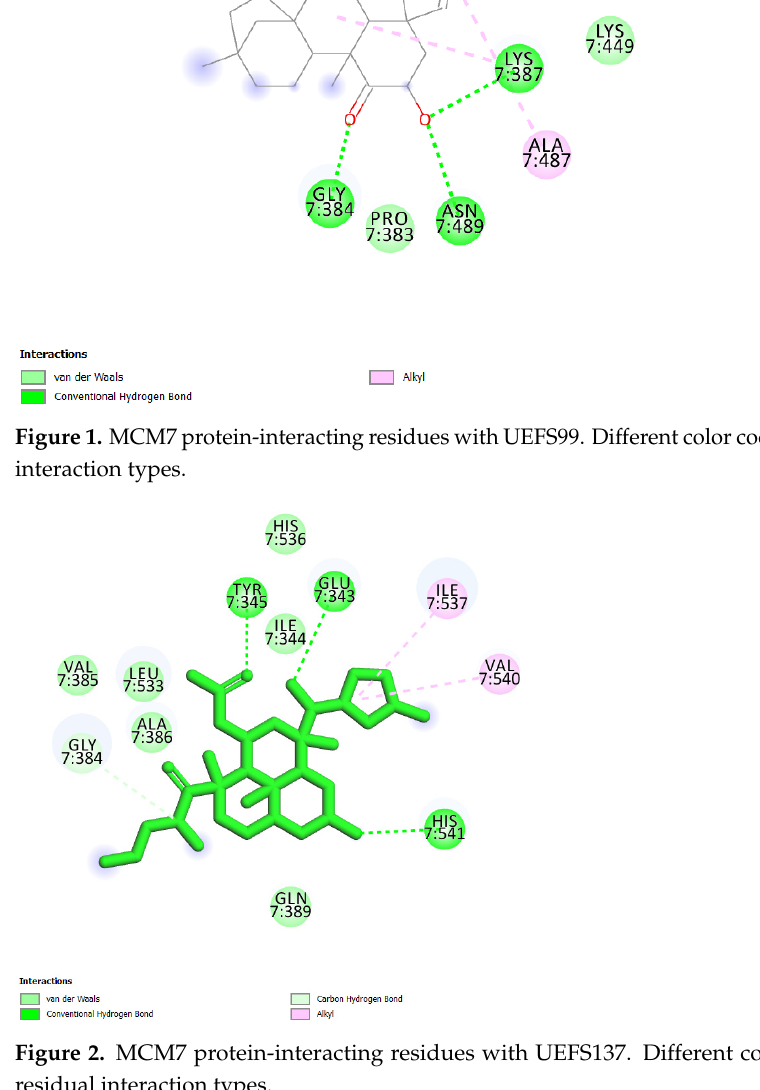
Figure 3. MCM7 protein-interacting residues with UEFS428. Different color code represents the residual interaction types. BE and inhibition constant for ꞌ UEFS99-MCM7 ꞌ , ꞌ UEFS137-MCM7 ꞌ , and ꞌ UEFS428- MCM7 ꞌ complexes were found to be ꞌ − 9.95 kcal/mol and 2.49 µM ꞌ , ꞌ − 8.92 kcal/mol and 5.13 µM ꞌ , and ꞌ − 8.71 kcal/mol and 9.53 µM ꞌ , respectively (Table 1).